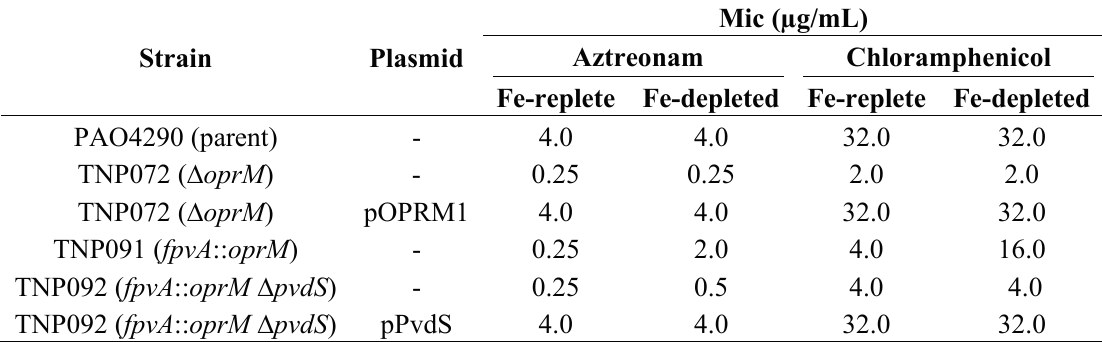
Mic (µg/mL) Aztreonam Chloramphenicol Fe-replete Fe-depleted